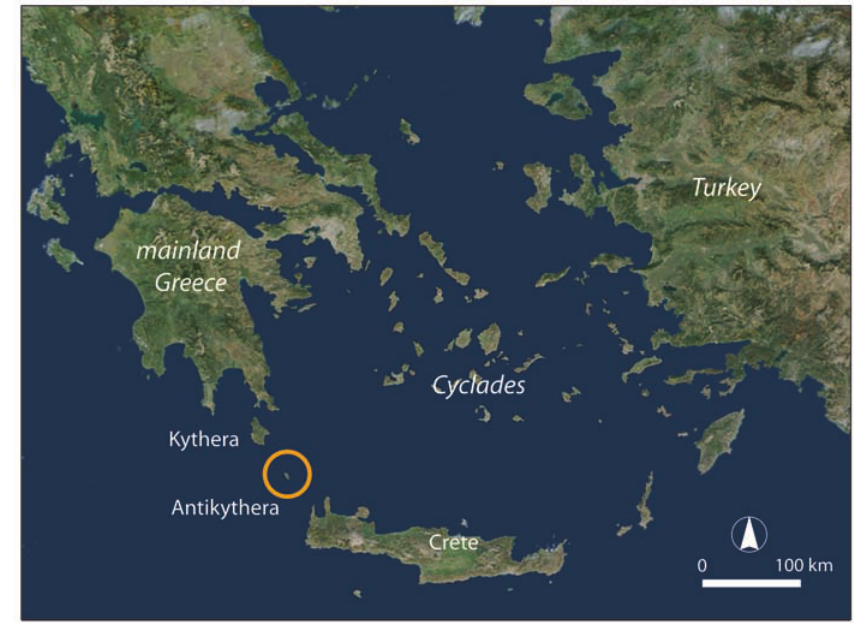
Figure 1 The Aegean with Antikythera circled in orange (original image courtesy of NASA, Terra- Modis).